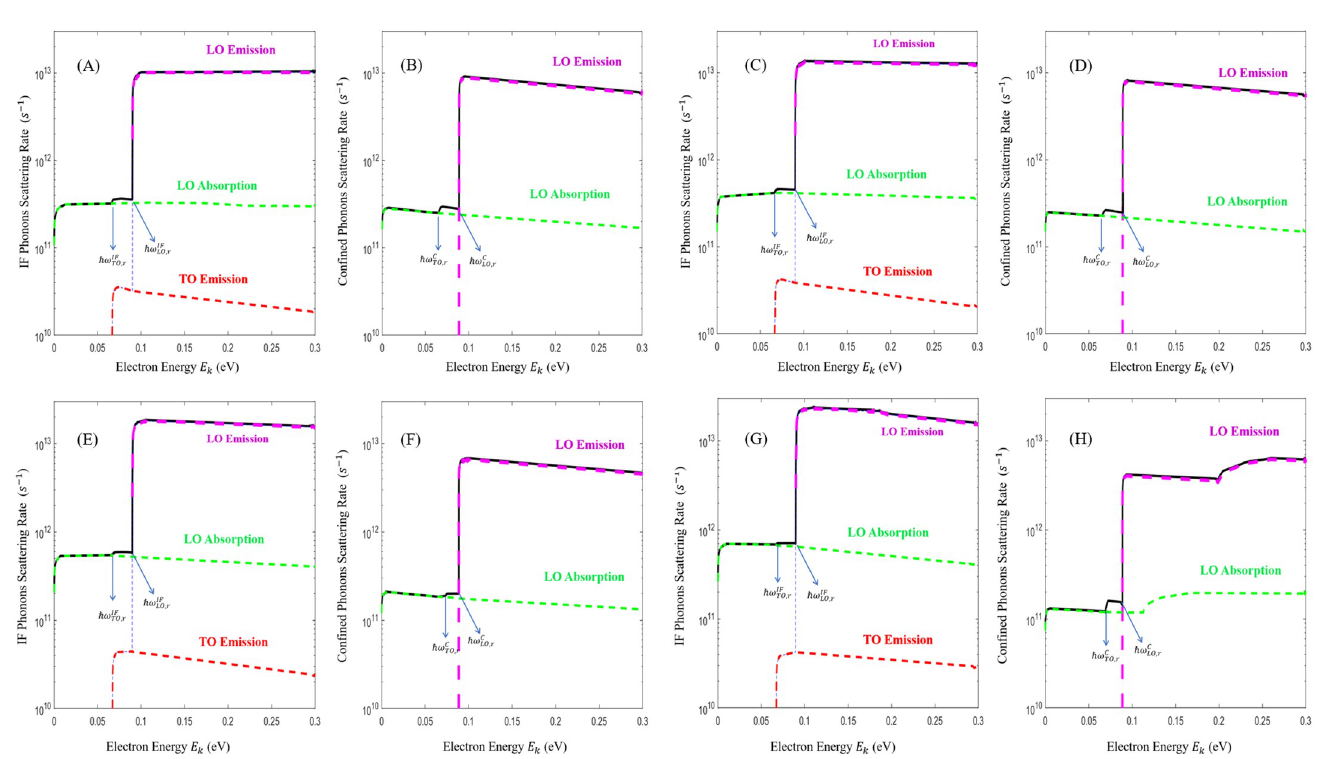
Fig 5. Total emission electron scattering rate as a function of the electron energy in the three-layered heterostructure of wurtzite GaN/InGaN/GaN quantum wells. The case d = 5 nm is shown for interface in Fig 5A and confined in Fig 5B. The thickness is set to 4nm in Fig 5C and Fig 5D, 3 nm in Fig 5E and Fig 5F and 2 nm in Fig 5G and Fig 5H. Only the phonon-assisted emission for IF (Fig 5A, 5C, 5E and 5G) and confined modes (Fig 5B, 5D, 5F and 5H) is considered. The black solid line corresponds to the total emission rate which is the sum of the IF LO emission, LO absorption and the TO emission rates. For both symmetric and asymmetric emission, the magenta line corresponds to LO emission rates, the green line corresponds to LO absorption rates, the red line corresponds to TO emission rates. The TO emission threshold energies are indicated by blue arrows and are labeled in the graphs as ℏ o C for confined and ℏ o IF for IF while the LO emission threshold energies are labeled TO ; r TO ; r as ℏ o C for confined and ℏ o IF for LO ; r LO ; r